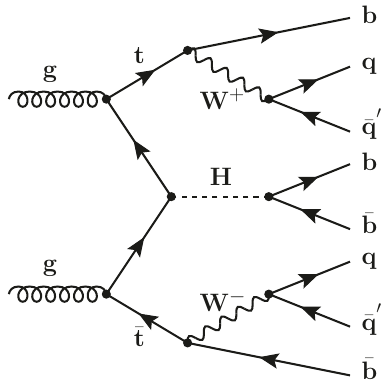
Figure 1 . An example of an LO Feynman diagram for ttH production, including the subsequent decay of the top quark-antiquark pair, as well as that of the Higgs boson into a bottom quark- antiquark